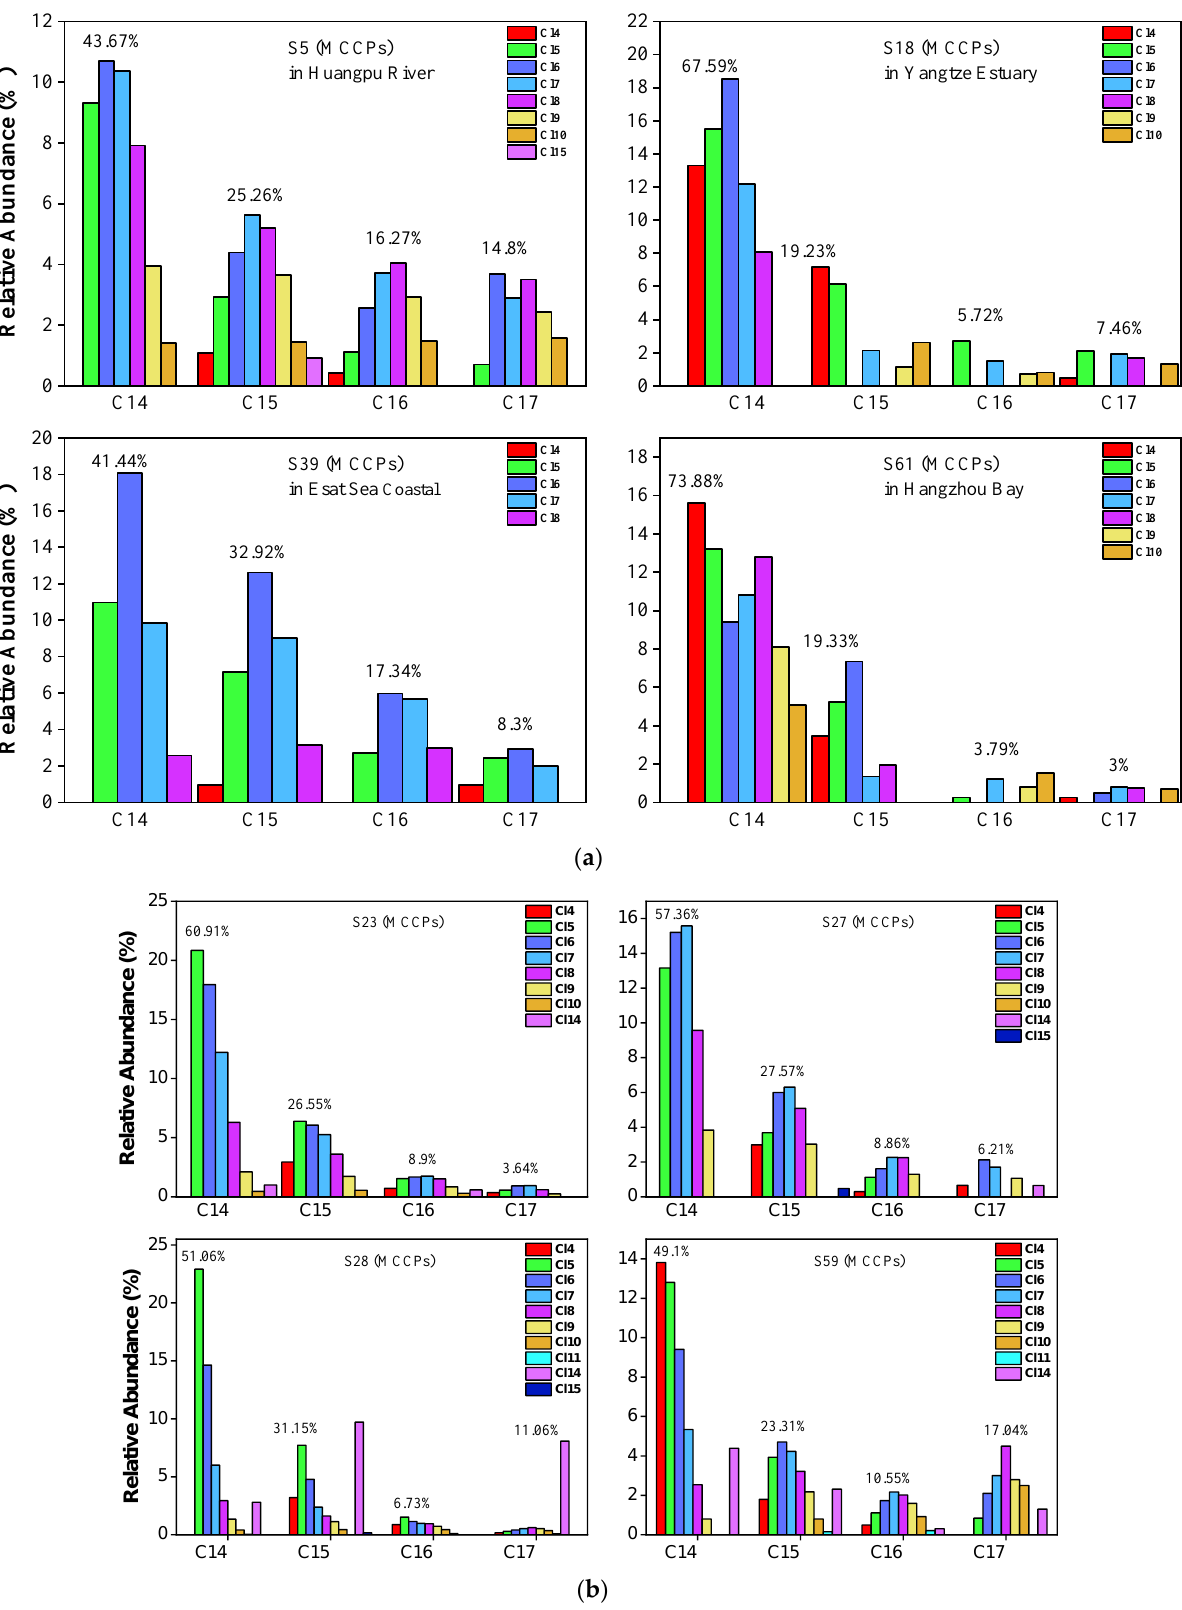
Figure 5. ( a ) Representative congener group abundance profiles of MCCPs in surficial sediments collected from the Huangpu River, Yangtze Estuary, East Sea Coastal, and Hangzhou Bay. ( b ) Representative congener group abundance profiles of MCCPs in surficial sediments from the dredging sediment discarding area.